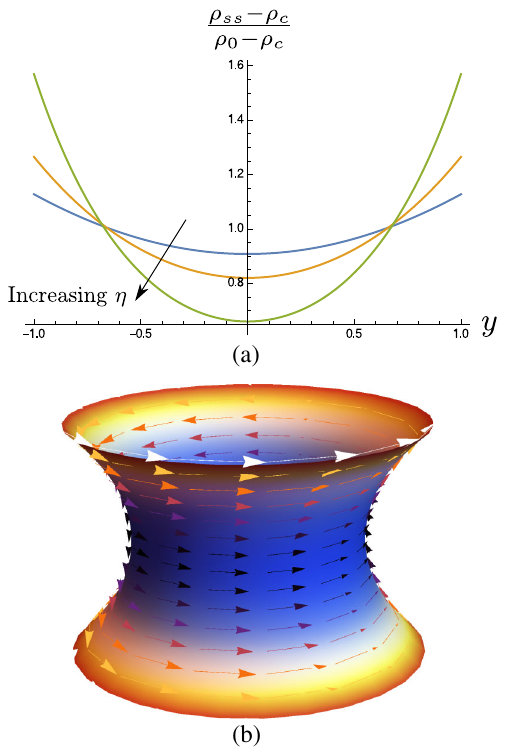
FIG. 5. (a) The normalized density profile of a polar flock on a catenoid given in Eq. (40), for η ¼ 0 . 5 (blue line), 1 (orange line), and 2 (green line). Note that, unlike the sphere, the density grows near the edge of the catenoid. (b) The density and polarization (for η ¼ 2 ), now shown on the catenoid. As before, blue corresponds to low-density regions (at the neck) and red to high-density regions.